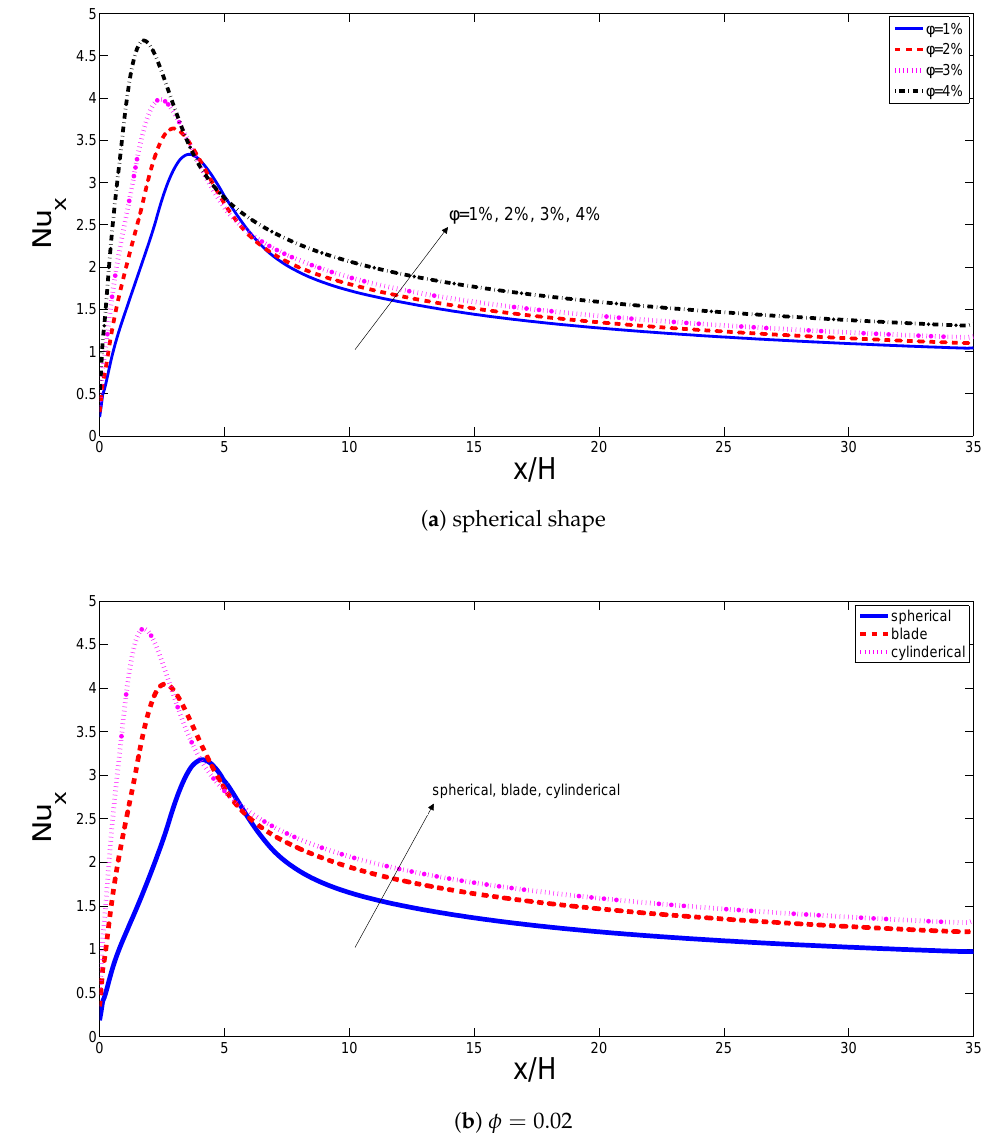
Figure 5. Effects of the particle shape and volume fraction on the local Nusselt number distribution along the hot bottom wall downstream of the